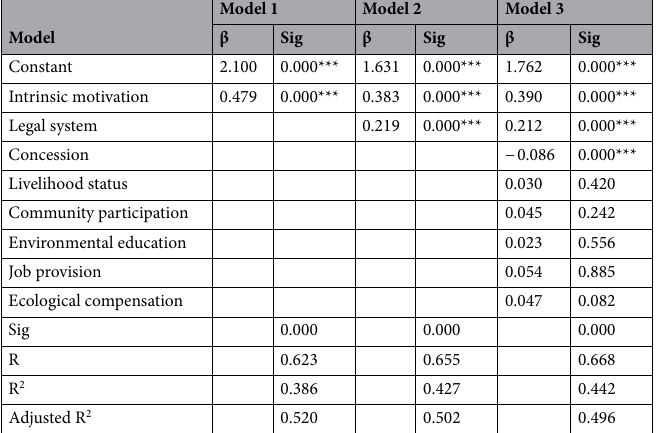
Table 2. Multiple linear regression model for pro-environmental behavior. ***p <